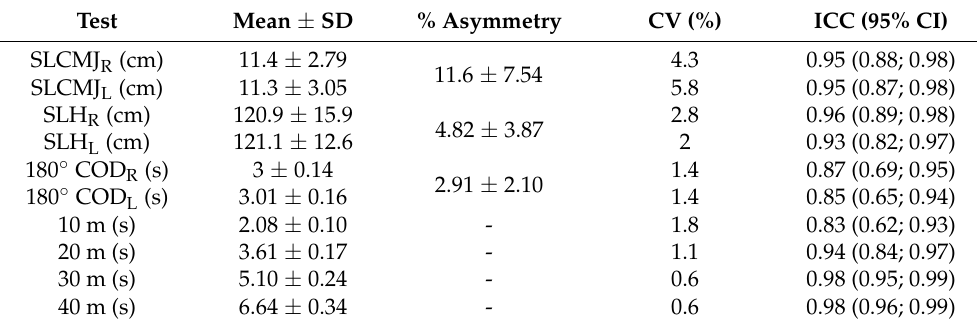
Table 1. Mean test scores ± standard deviation (SD) and reliability for all players.